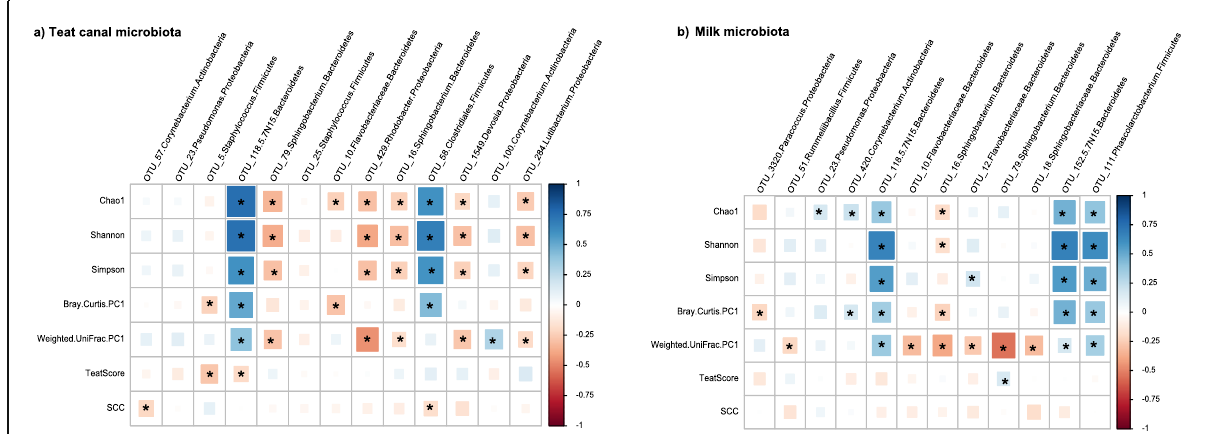
Fig. 4 Relationships of hub OTUs with biodiversity metrics of mammary gland and udder health parameters. Spearman ’ s correlation coefficient was used to explore the relationships between the relative abundances of a ) teat canal, and b ) milk hub OTUs and community richness (Chao1 index of richness), α -diversity (Shannon ’ s and Simpson ’ s indices of diversity), β -diversity (Bray-Curtis dissimilarities and weighted UniFrac distances of microbial communities) metrics as well as udder health parameters including teat end hyperkeratosis scores and somatic cell counts (SCC) of the milk samples. “ * ” Indicates p -value <0.05. The color ramp and the size of the squares indicate the type and strength of the Spearman ’ s correlation coefficient (rho): rho =1 showing strong positive correlation and rho= − 1 showing strong negative correlation between the two